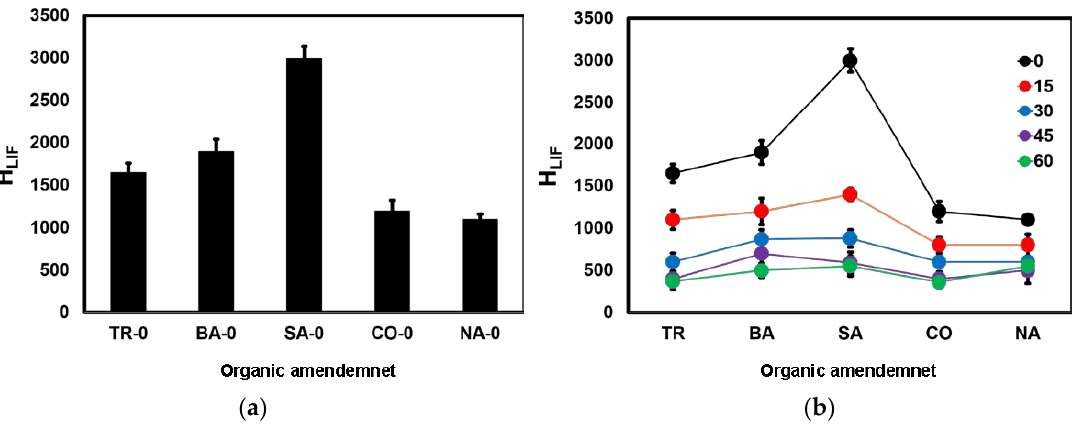
Figure 2. Humification index (H LIF ) ( a ) of the composts without charcoal addition, and ( b ) of the organic amendments with charcoal addition. Composts were made from poultry industry wastes added with tree trimmings (TR), sugarcane bagasse (BA), sawdust (SA), cotton residue (CO), and Napier grass (NA). The numbers 0, 15, 30, 45, and 60 correspond to the proportion of charcoal in the organic amendment (%, weight basis). Error bars represent standard deviations.